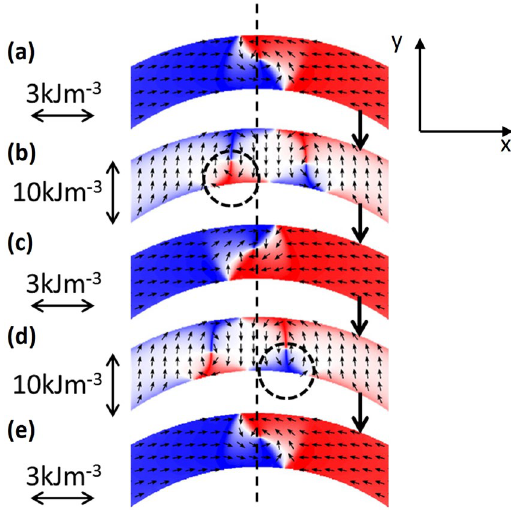
Figure 3. Micromagnetic simulations of a head to head vortex domain wall under the action of a uniaxial magnetic anisotropy energy. (a ) to ( e ) show successive switching of the chirality of the vortex wall. The transitions from panels (a) and (c) to panels (c) and (e) respectively involve the reversal of the x-component of the magnetisation in the regions marked by dashed circles in ( b ) and ( d